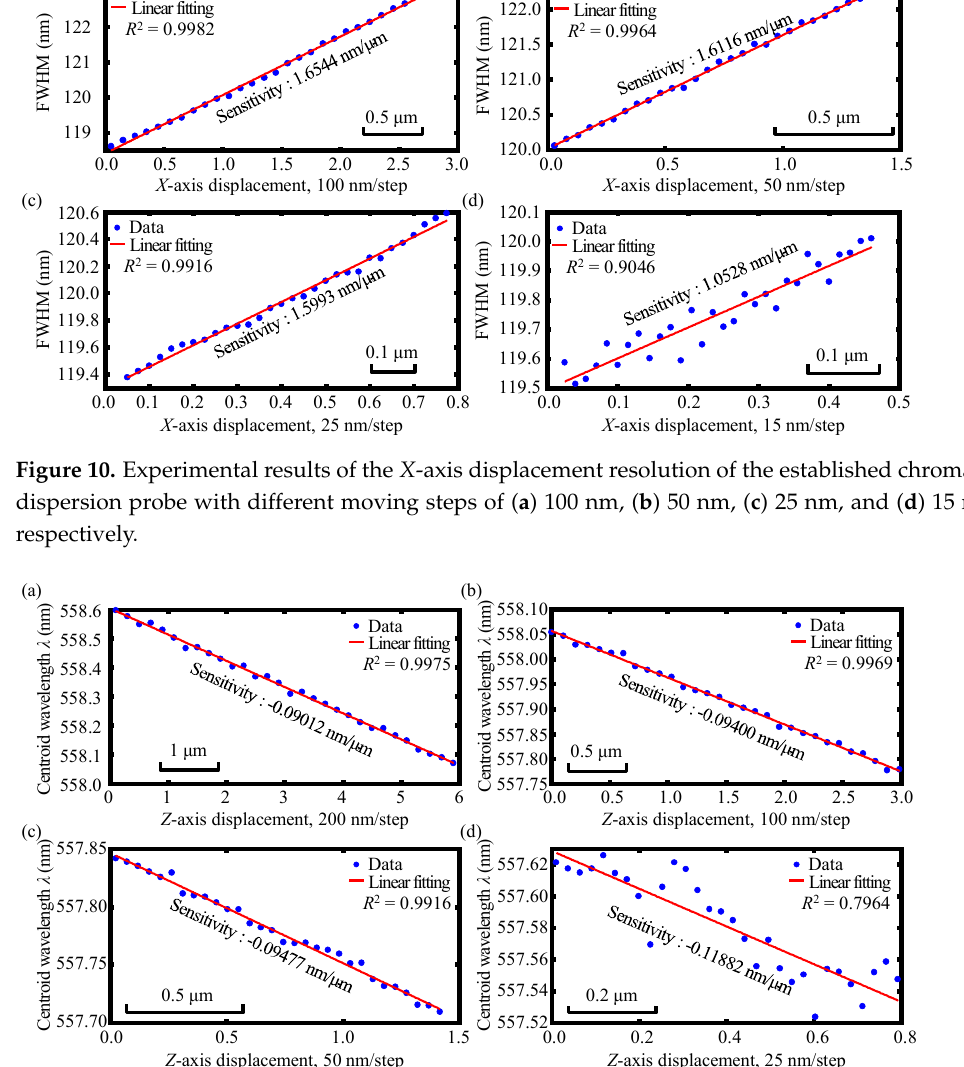
Figure 11. Experimental results of the Z -axis displacement resolution of the established chromatic dispersion probe with different moving steps of ( a ) 200 nm, ( b ) 100 nm, ( c ) 50 nm, and ( d ) 25 nm, respectively.